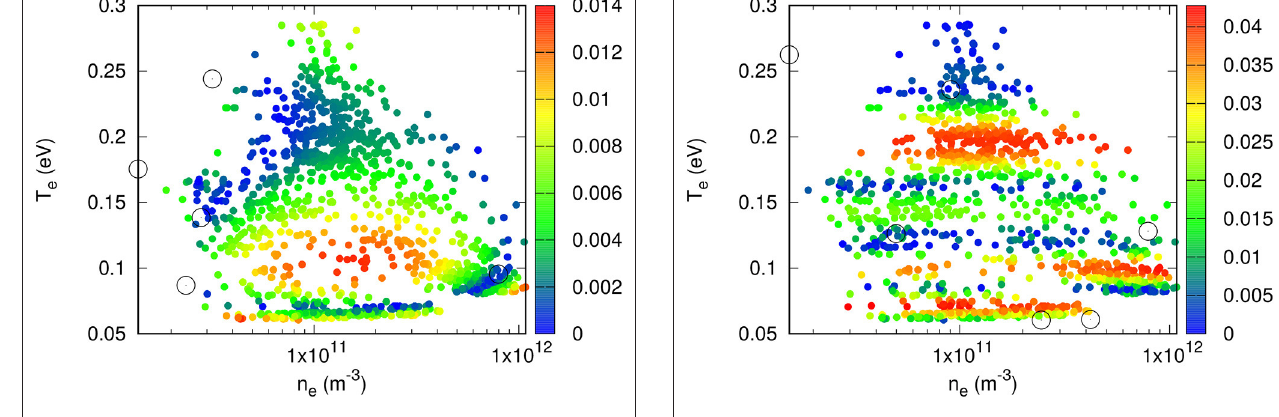
FIGURE 6 | Color plot of relative errors in model-inferred temperatures in a validation data set consisting of approximately 5,000 randomly selected points. Circles show the positions of the six directly optimized pivots used to construct the kriging model.